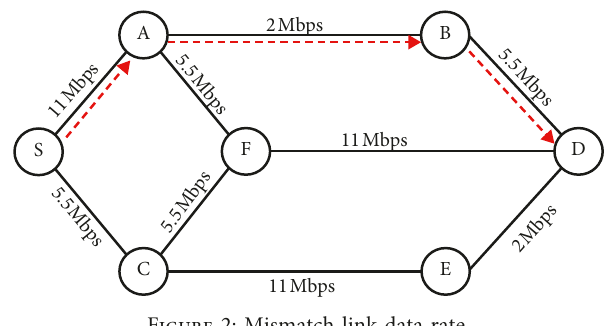
Figure 2: Mismatch link data